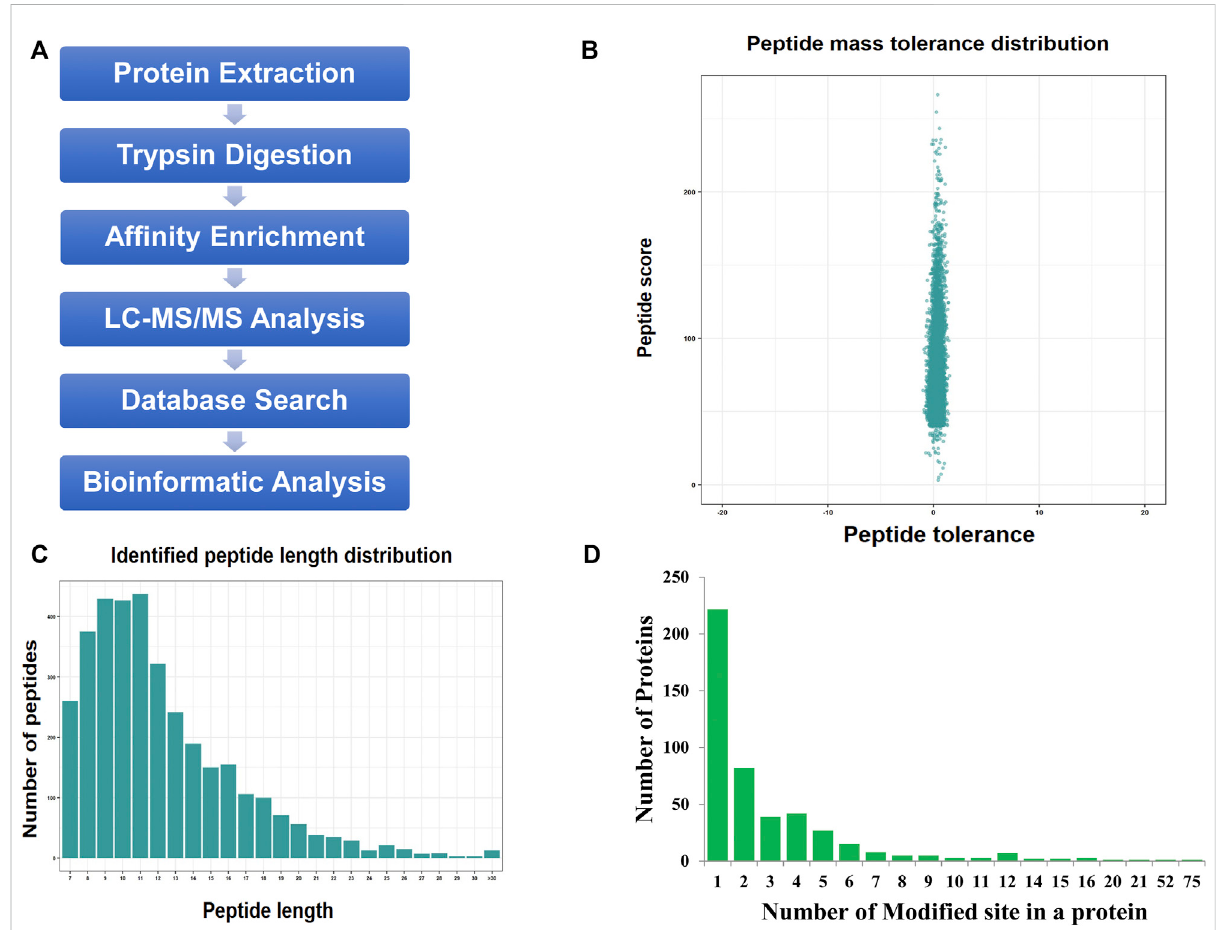
Protein lysine lactylation assay of F. occidentalis . (A) Technical route of Klac assay. (B) Mass error range for all identi fi ed Klac peptides (The error distribution for Klac peptides is close to 0, and the vast majority are less than 0.02 Da). (C) Klac peptide length range (Most of the peptides are distributed in 7 – 20 amino acids, which conform to the general rules based on trypsin enzymatic hydrolysis and HCD fragmentation). (D) Number of Klac sites in the protein of F. occidentalis (Most of the Klac proteins have less than three modi fi cation